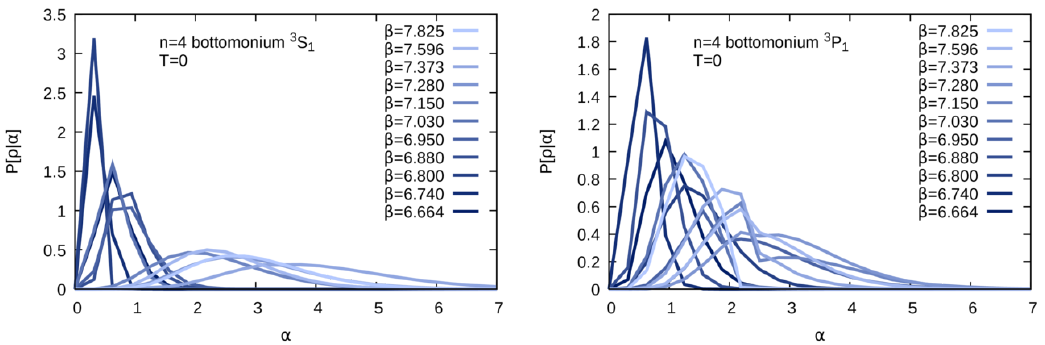
Figure 31 . Representative examples of the probability distribution over the hyperparameter (cid:11) used in the self consistent determination of the most probable spectrum at zero temperatures. We show here bottomonium results, the left panel contains the S-wave results, the right panel the P-wave